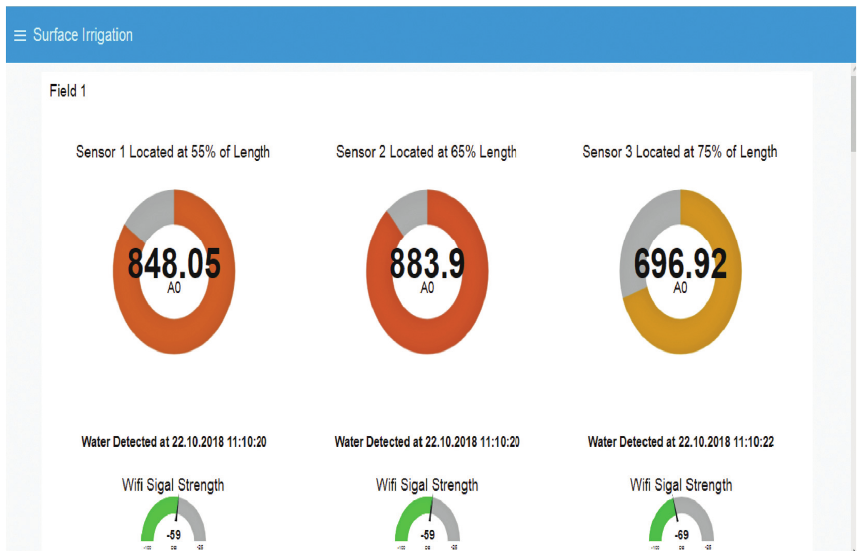
Figure 6: On-site analysis data on IoT platform.